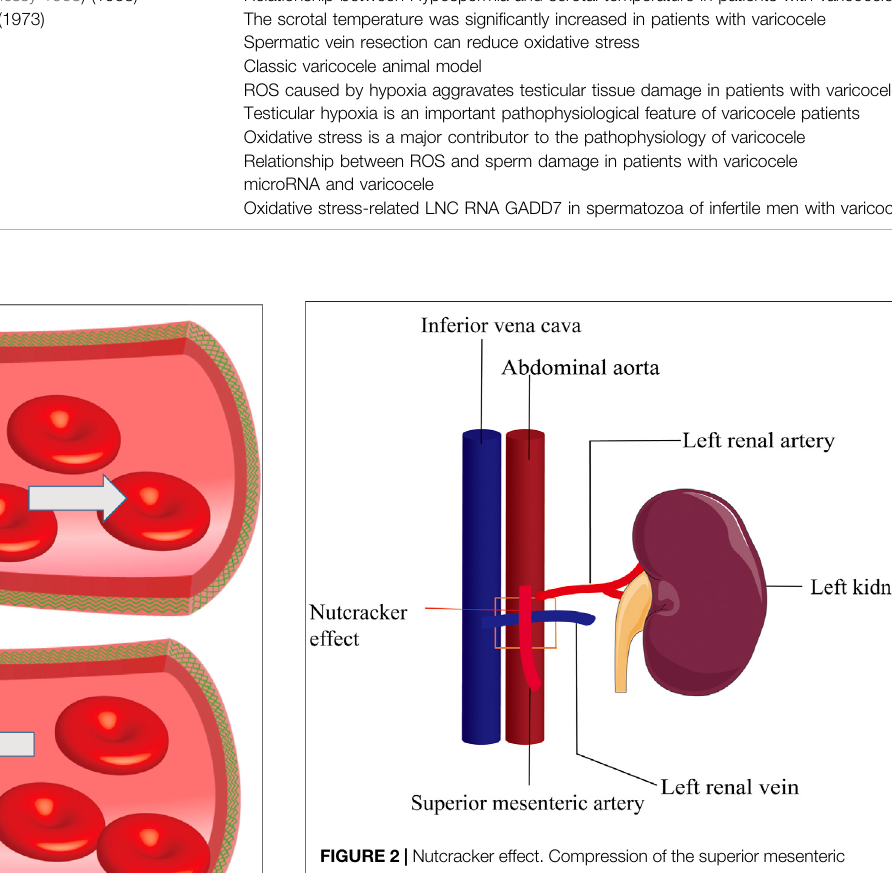
FIGURE 2 | Nutcracker effect. Compression of the superior mesenteric arteryontheleft renalveinleadstoelevated renalveinpressureandspermatic vein return disturbance. The square area represents the superior mesenteric artery pressing against the renal